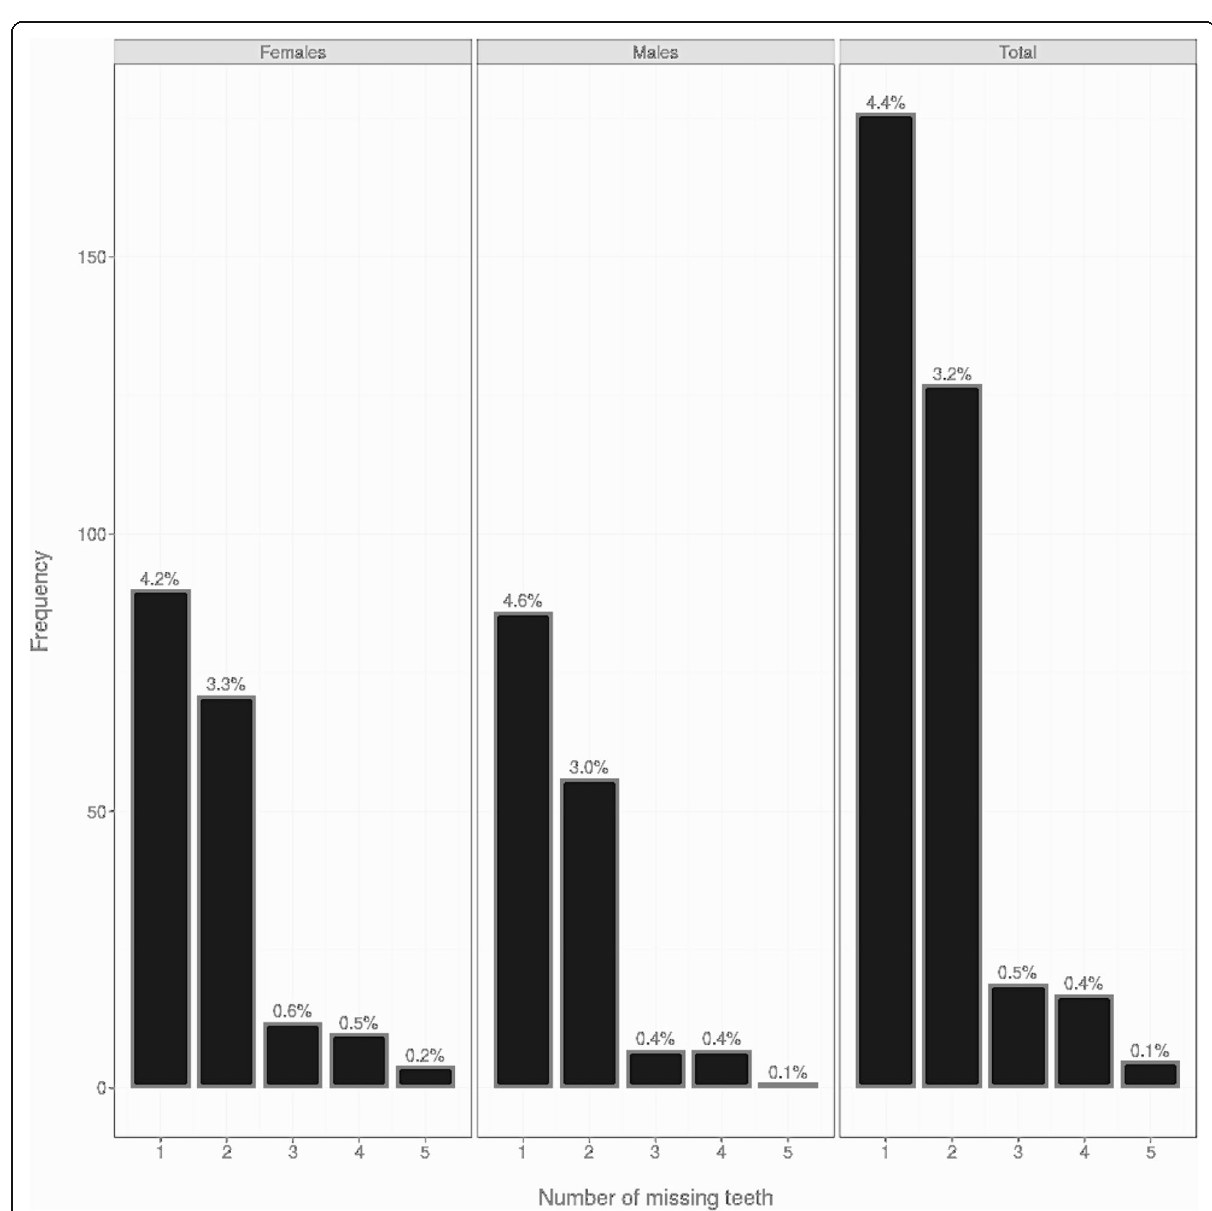
Fig. 1 Frequencies and percentages of agenesis in males, in females, and in total